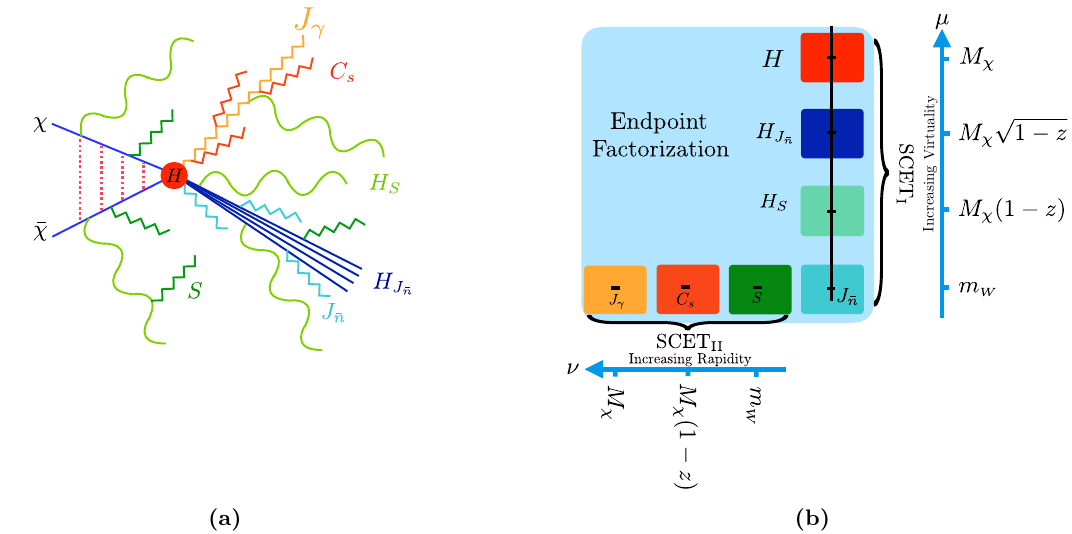
Figure 2 . A review of the factorization formula derived in [15]. (a) A schematic depiction of the relevant modes. (b) The virtuality and rapidity of the di(cid:11)erent